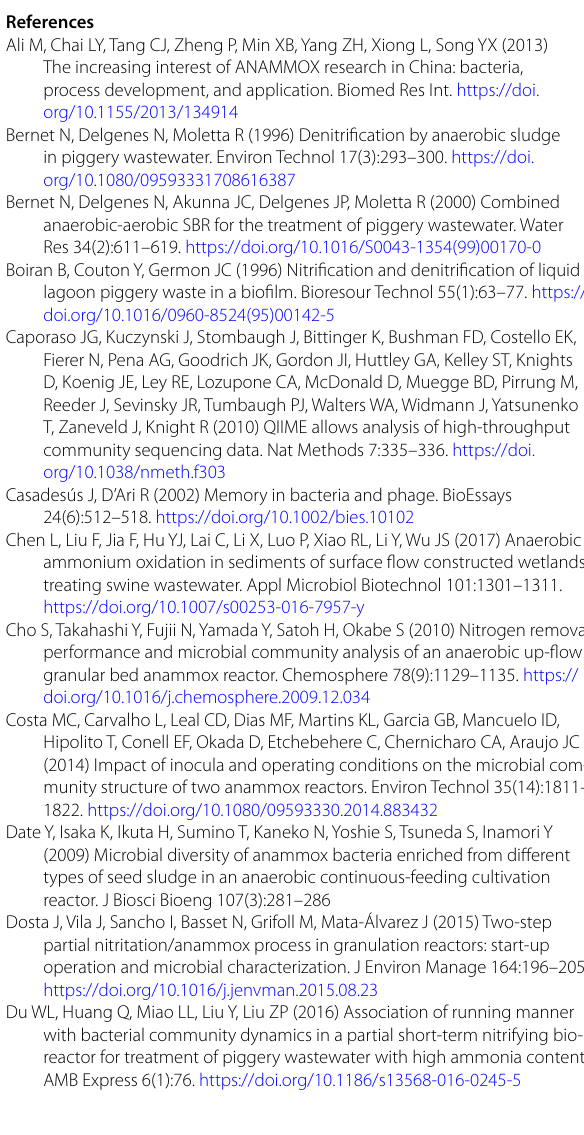
Additional file 1: Figure S1. Schematic diagram of the